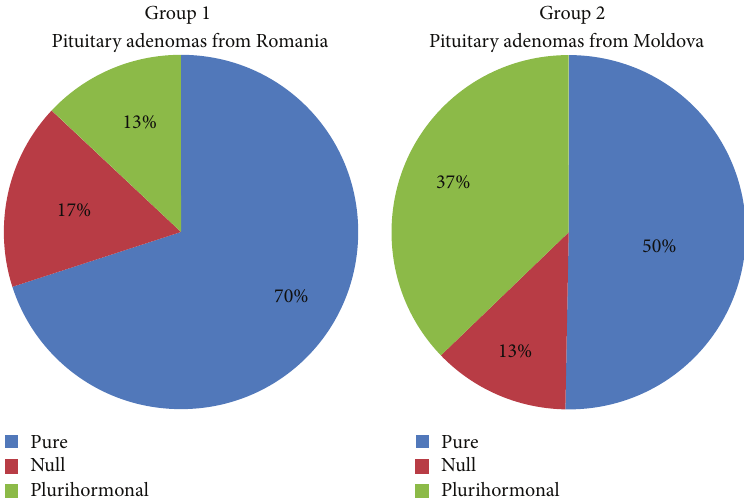
Figure 1: Comparative assessment of both groups regarding types of pituitary adenoma based on their immunoprofile. Percentage of pure, null cell adenomas and plurihormonal adenomas between group 1 (pituitary adenomas from Romania) and group 2 (pituitary adenomas from Moldova). The highest difference between these two groups was noticed for plurihormonal